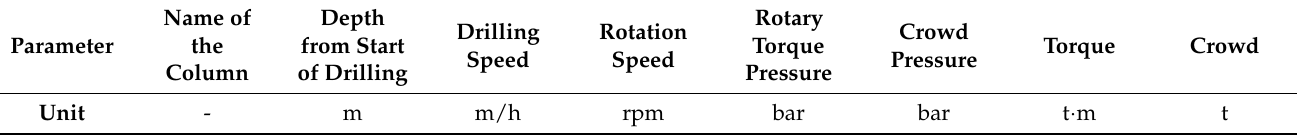
Table 3. MWD available data.